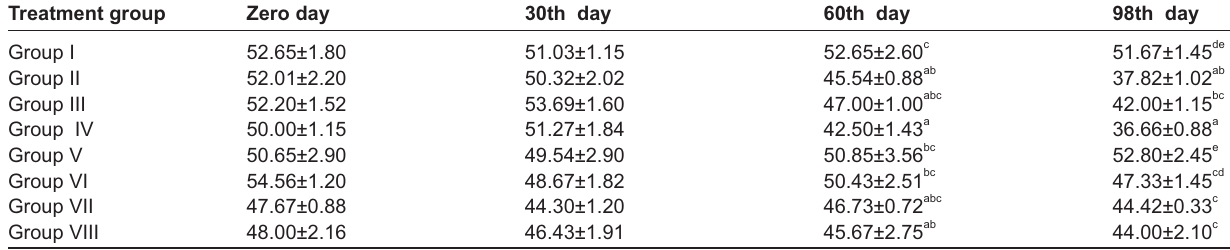
Table-2. Effect of oral administration of chlorpyriphos, lead acetate, vitamin C alone, and in combinations on blood glutathione levels (nmol/ml) in rats. Treatment